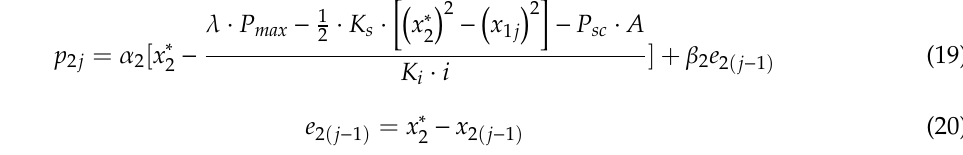
Figure 12. Simulation model of the FPEG. The solver chosen for simulation was ode23 ， the maximum step size was 10-7, and time tolerance was 10*128*eps. The simulation parameters determined by the structure of the prototype are shown in Table 2.